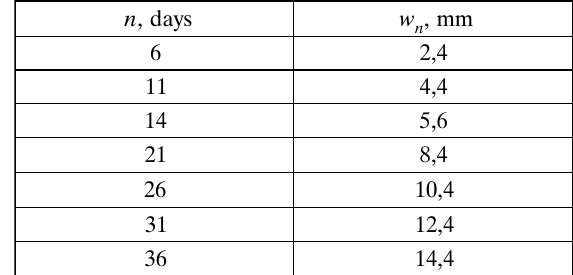
Table 4. n versus w